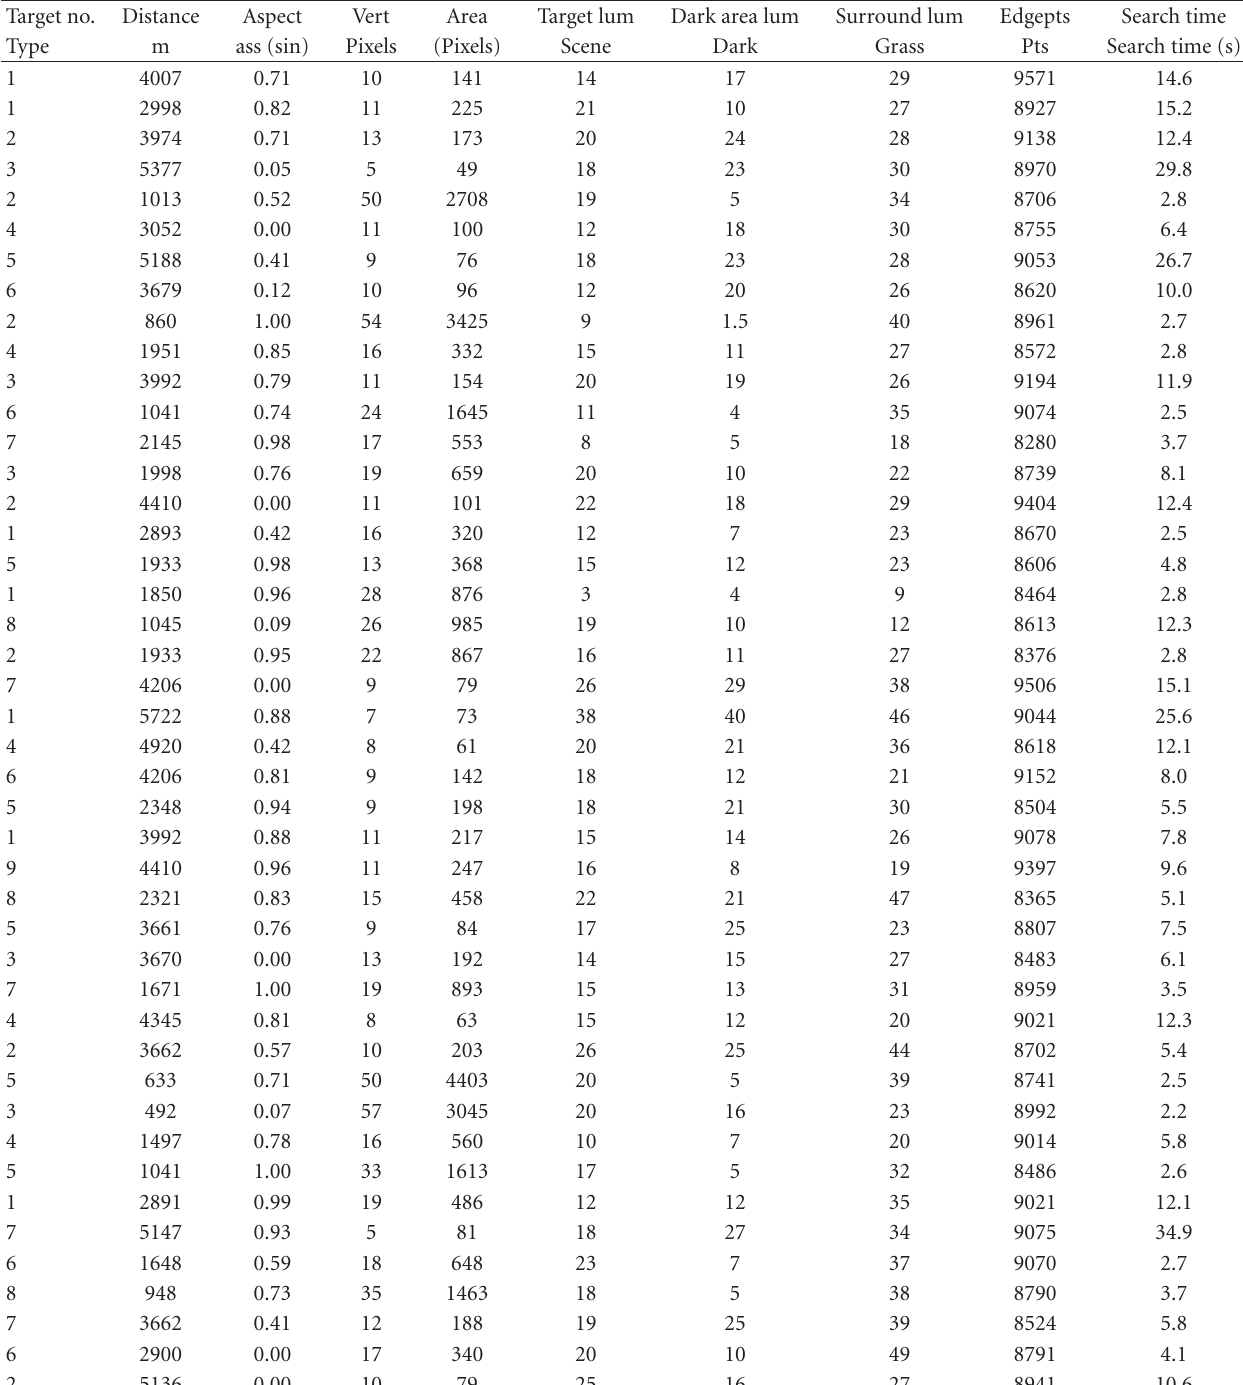
Table 1: Data reproduced from [1]. Data representing the target classification, and the various extracted attributes of the visual scene. Target